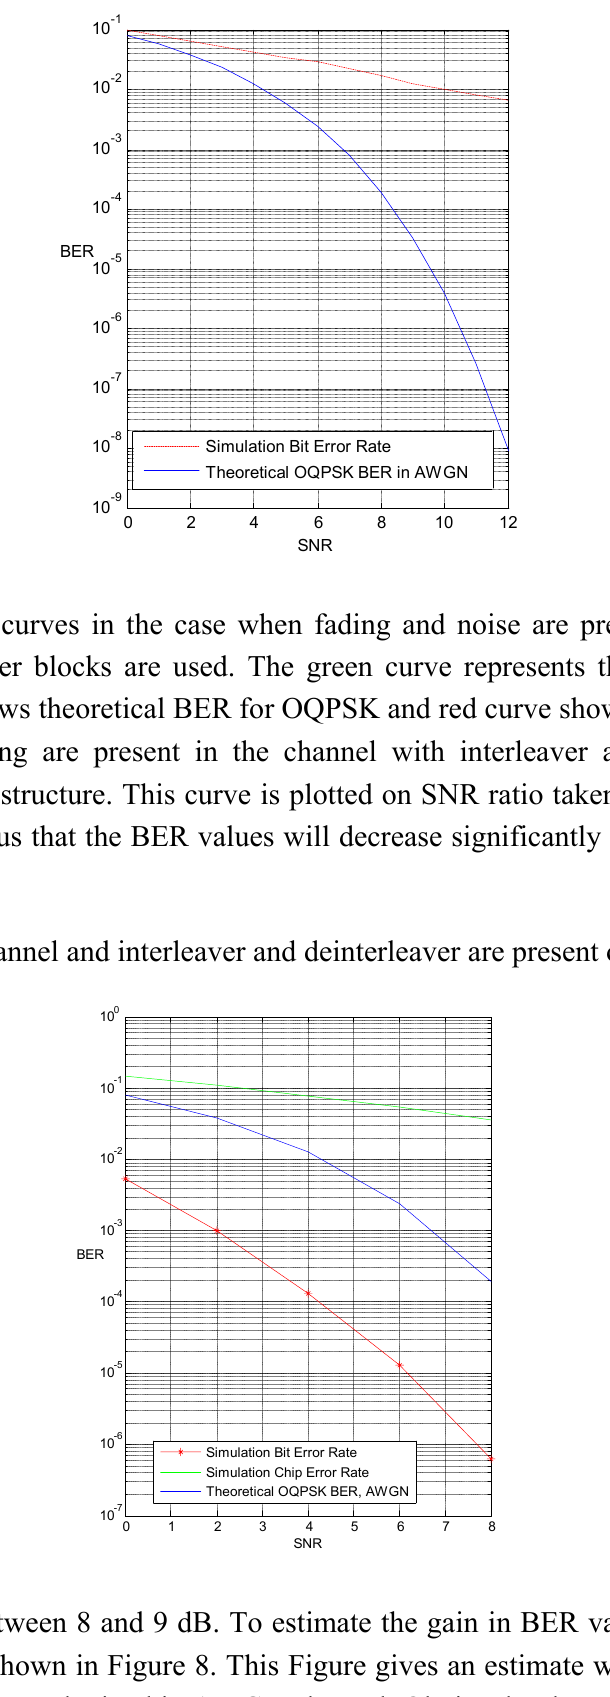
Figure 6. Rayleigh fading and AWGN are present in the channel.